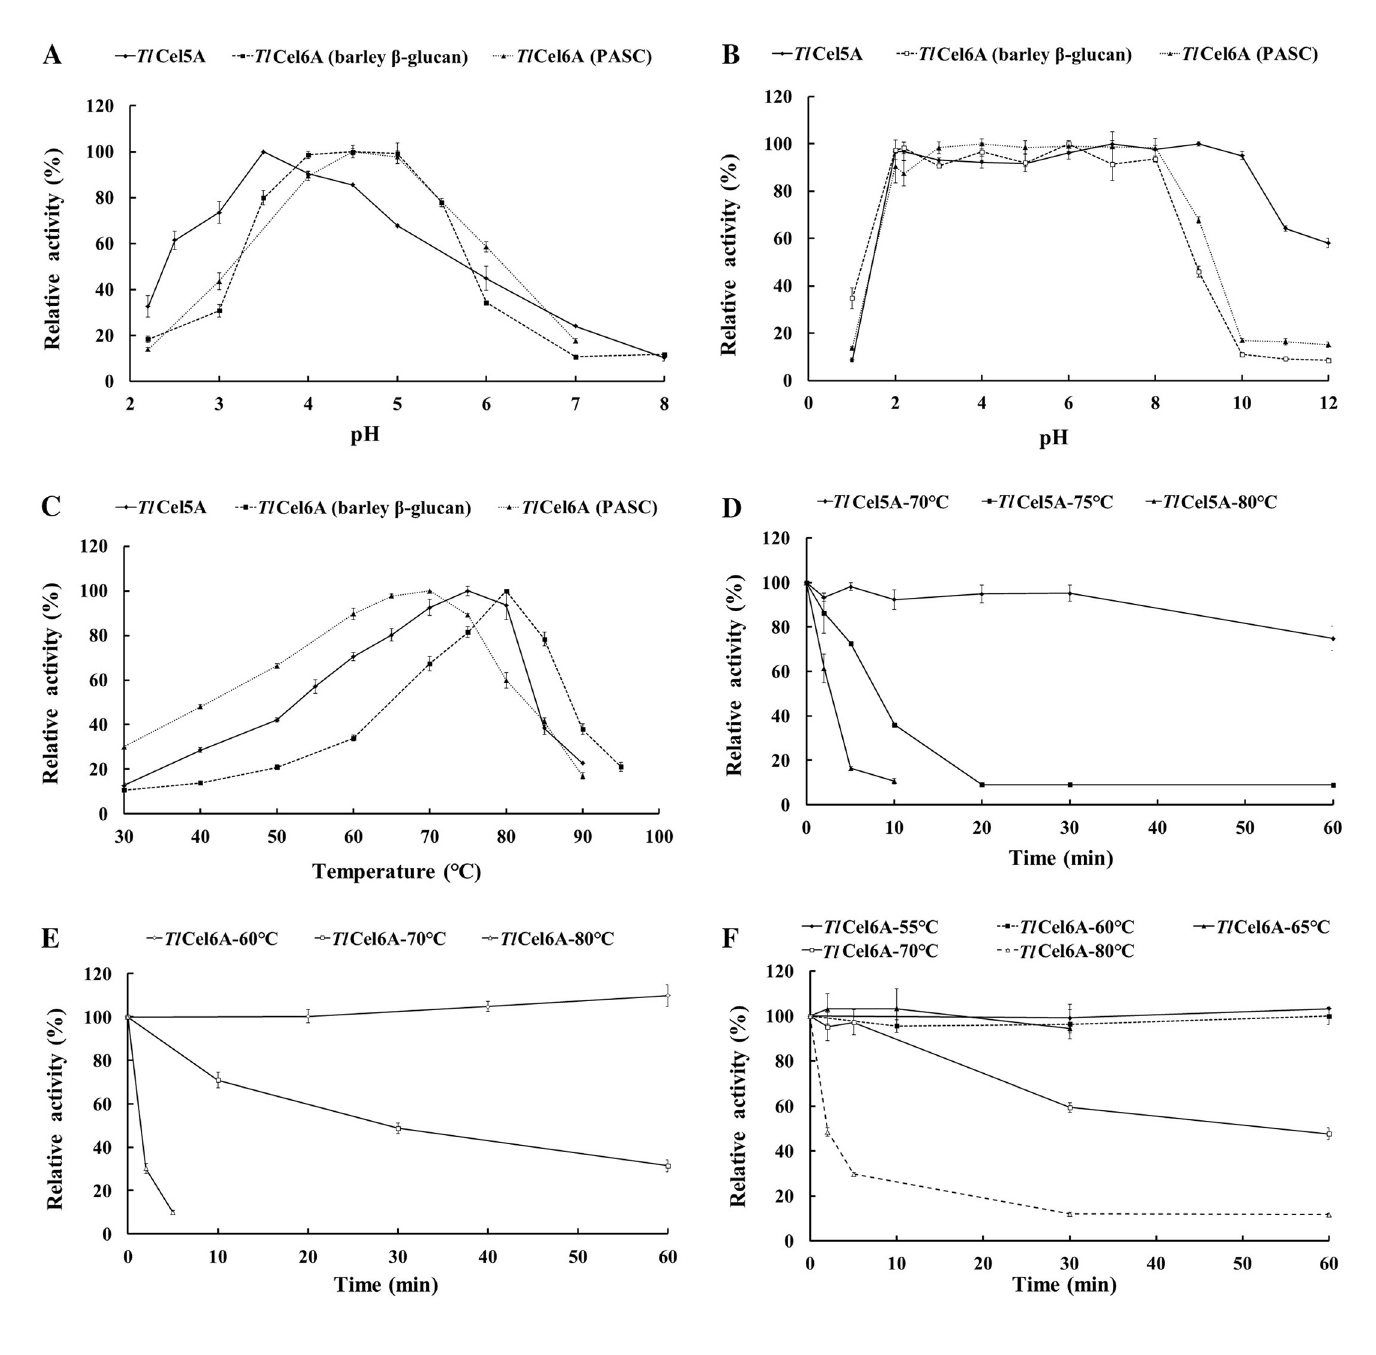
Fig 2. Effects of pH and temperature on the enzyme activity and stability of purified recombinant Tl Cel5A and Tl Cel6A. (A) pH-activity profiles. Tl Cel5A was incubated at 75˚C for 10 min with 1.0% (w/v) CMC for enzyme assays. The enzymatic activities of Tl Cel6A were measured at 70˚C against barley β -glucan and 80˚C for PASC for 10 min, respectively. (B) pH stability of Tl Cel5A and Tl Cel6A after 1 h-incubation at 37˚C. The enzyme activities were measured under standard conditions. (C) Temperature-activity profiles of Tl Cel5A and Tl Cel6A assayed at optimal pH for 10 min. (D) Tl Cel5A thermostability at 70, 75 and 80˚C and pH 3.5 for various durations. (E) Tl Cel6A thermostability at 60, 70 and 80˚C and pH 4.5 with barley β -glucan as the substrate. (F) Tl Cel6A activities measured at 55, 60, 65, 70 and 80˚C and pH 4.5 with PASC as the substrate. Each value in the panel represents the means ± SD (n = 3).